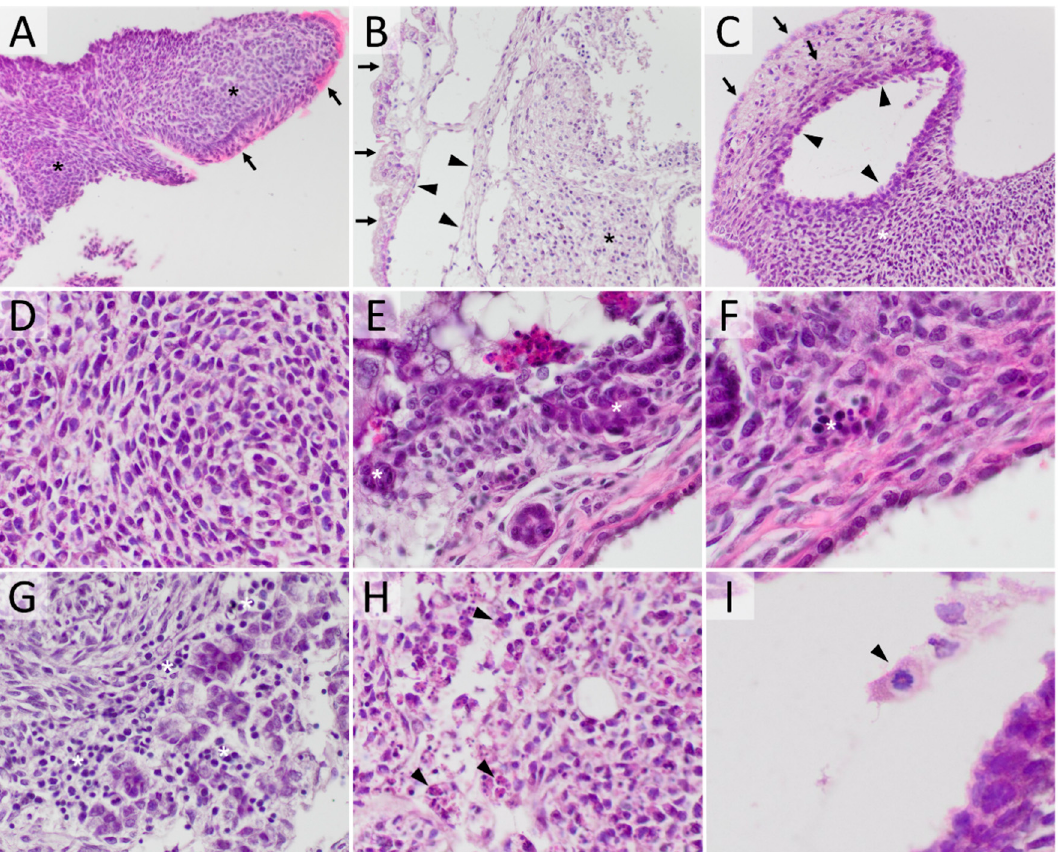
Figure 1. Experimental mouse teratoma morphology. ( A ) teratoma consisting mostly of undifferentiated tissue (asterisk—cords and sheets of mainly monomorphic cells with high mitotic activity and without any visible forming structure), while on the surface clearly differentiated tissue is present (arrow—morphological cylindrical epithelial cells with eosinophilic cytoplasm and pseudostratified epithelial cells) (HE, 200×); ( B ) teratoma composed of differentiated tissue (arrow—surface epithelial cells, arrowhead—cystic structure lined by thin flattened epithelia), while the inside is mostly made up of UTC (asterisk) (HE, 200×); ( C ) the teratoma composed of all three germ cell-derived lines, mesodermal (asterisk), endodermal (arrowhead) and ectodermal (arrow) (HE, 200×); ( D ) high magnification of UTCs (HE, 400×); ( E ) high magnification of CSCLC (asterisk) (HE, 400×); ( F ) high magnification view of hematopoiesis (asterisk) (HE, 400×); ( G ) high magnification of lymphocytes (asterisk) (HE, 400×); ( H ) high magnification of cells in the process of apoptosis (arrowhead) (HE, 400×); ( I ) high magnification of a cell in the process of mitosis (arrowhead) (HE, 600×).